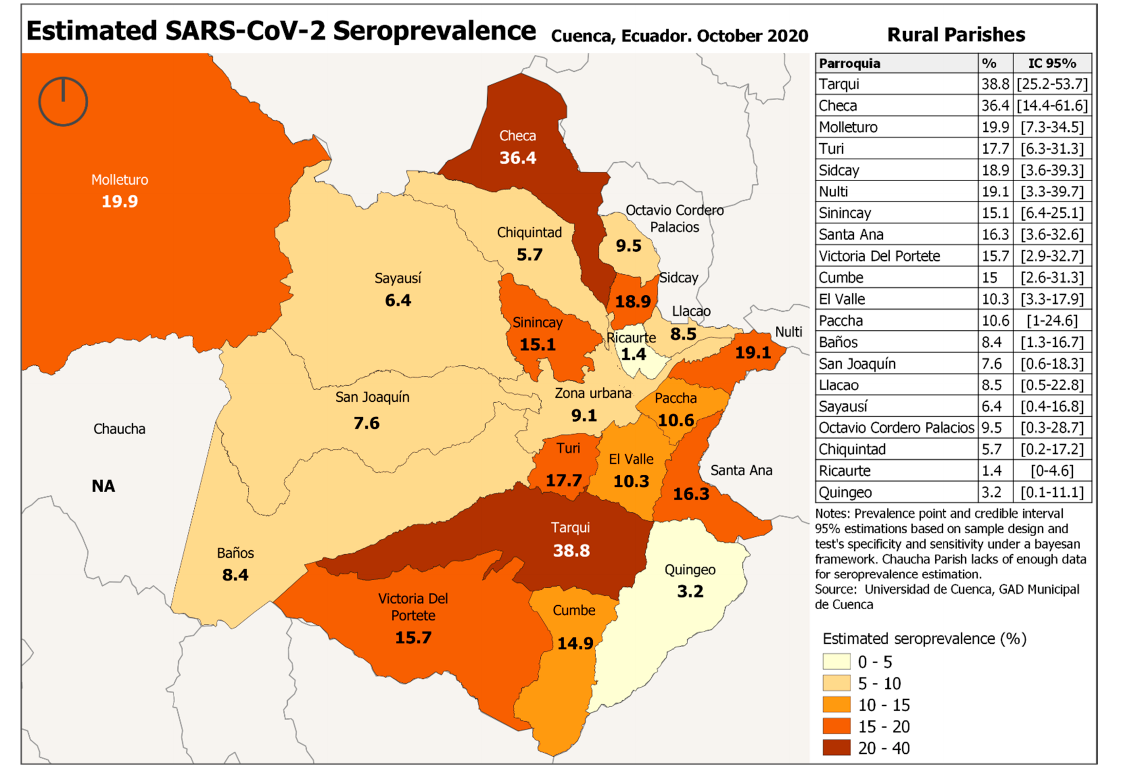
Figure 2. Estimated SARS-CoV-2 Seroprevalence, Cuenca, Ecuador 2020 Rural parishes. Int. J. Environ. Res. Public Health 2021 , 18 , x FOR PEER REVIEW